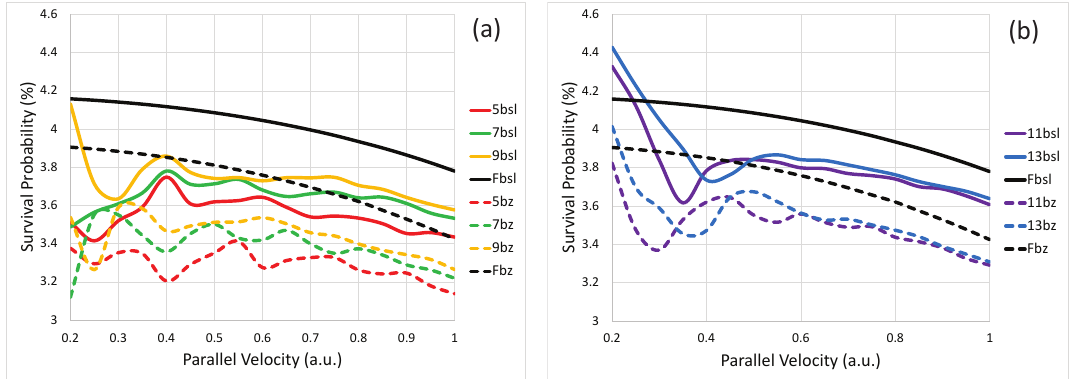
Figure 5. Same as Figure 4, but for vicinally stepped Au(100).